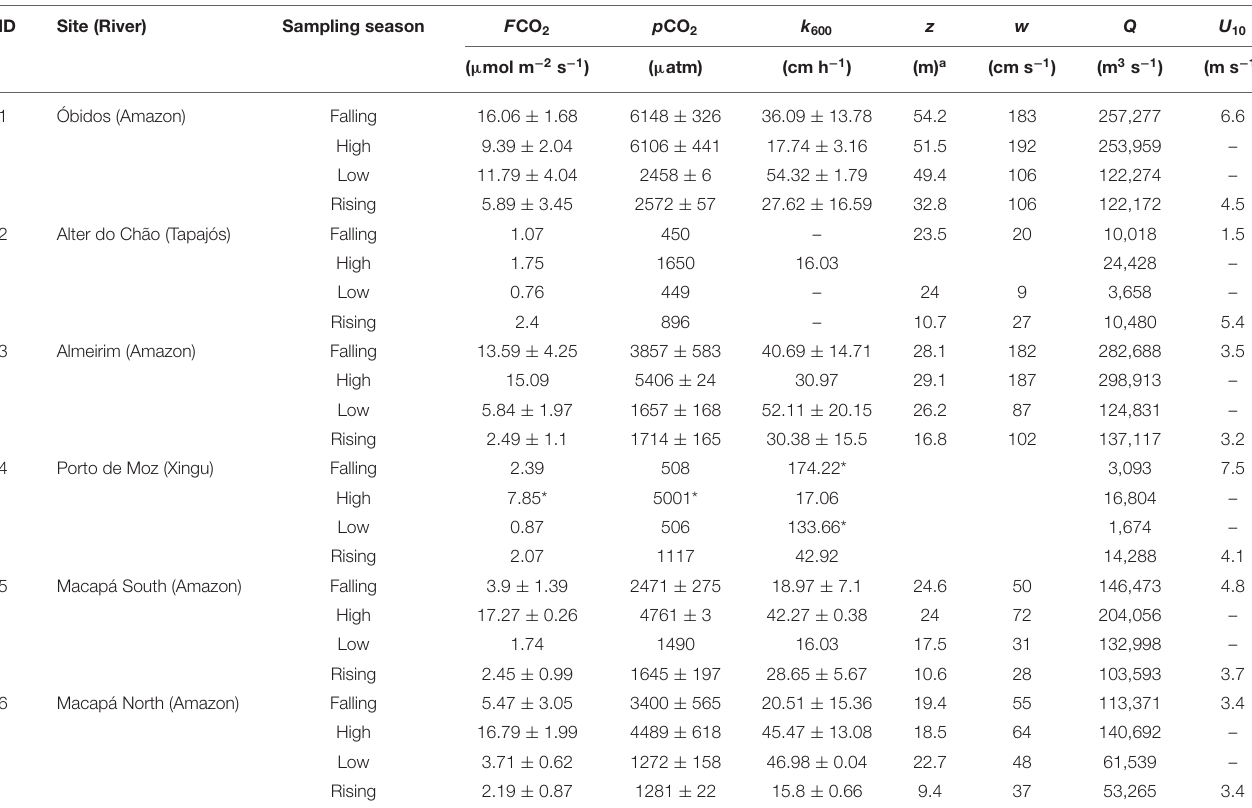
TABLE 1 | CO 2 fluxes to atmosphere ( F CO 2 ), partial pressure of CO 2 in the water ( p CO 2 ), gas transfer velocity ( k 600 ) measurements according to site and season (mean ± SD) and measurements of mean depth ( z ), water velocity ( w ), discharge ( Q ) and wind speed ( U 10 ).